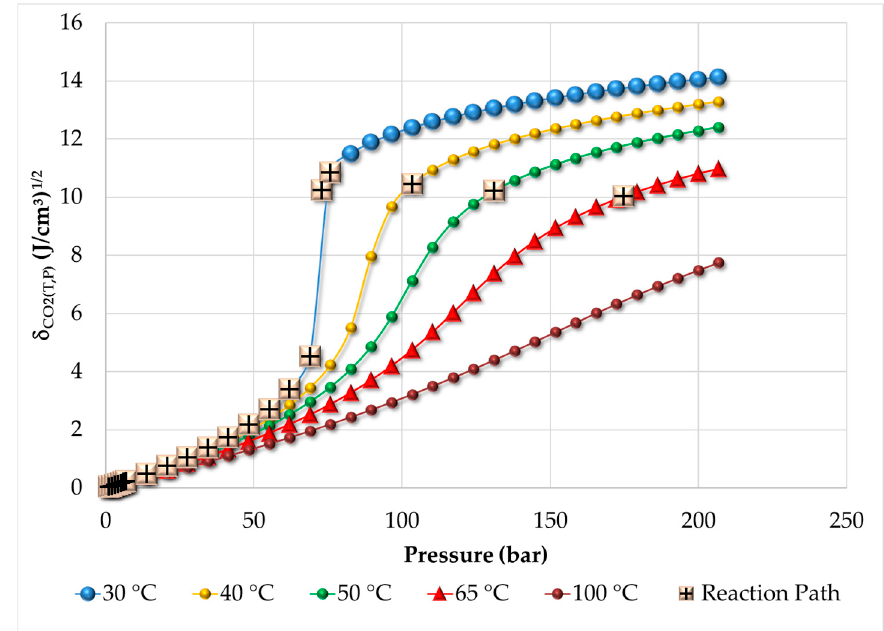
Figure 2. Estimation of the solubility parameters of carbon dioxide under subcritical and supercritical conditions, including the reaction path followed by the reactor.